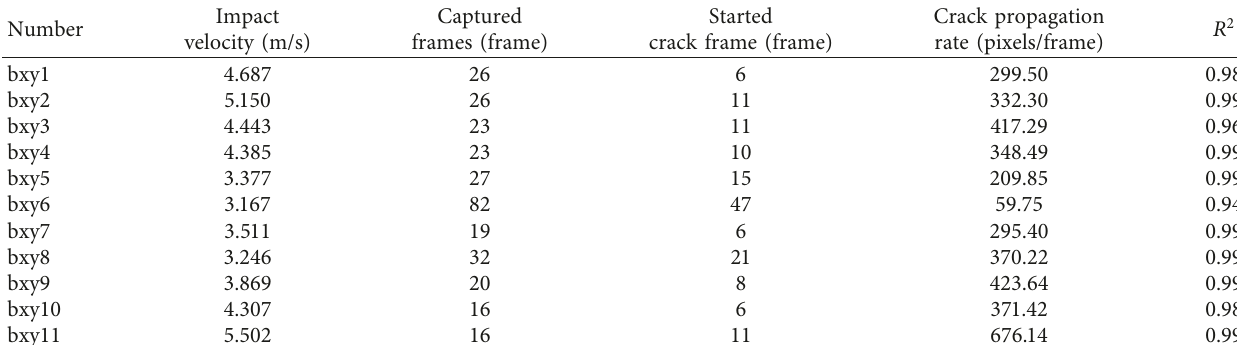
Table 3: Crack quantitative results.